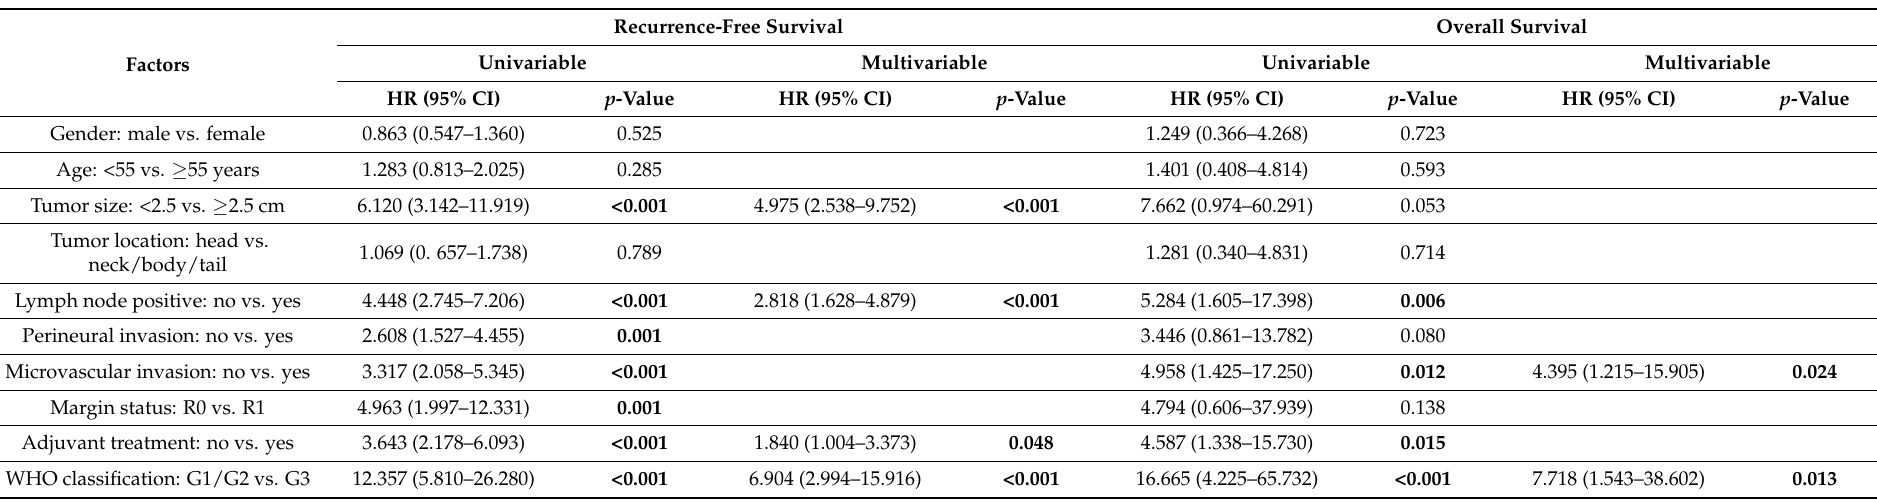
Table 2. Univariable and multivariable analysis of factors for recurrence-free survival and overall survival in patients with non-metastatic and resected NF-PanNETs. Recurrence-Free Survival Overall Survival